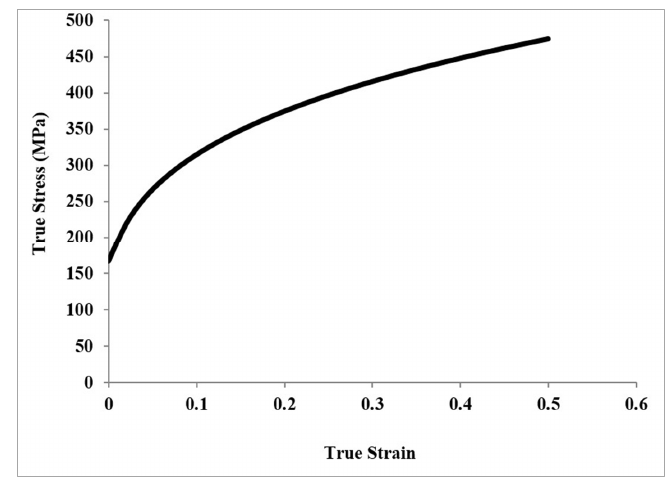
Figure 3. Plastic true stress–true strain curve of mild steel [30]. Table 2. The material properties of sheet metal blank [1].